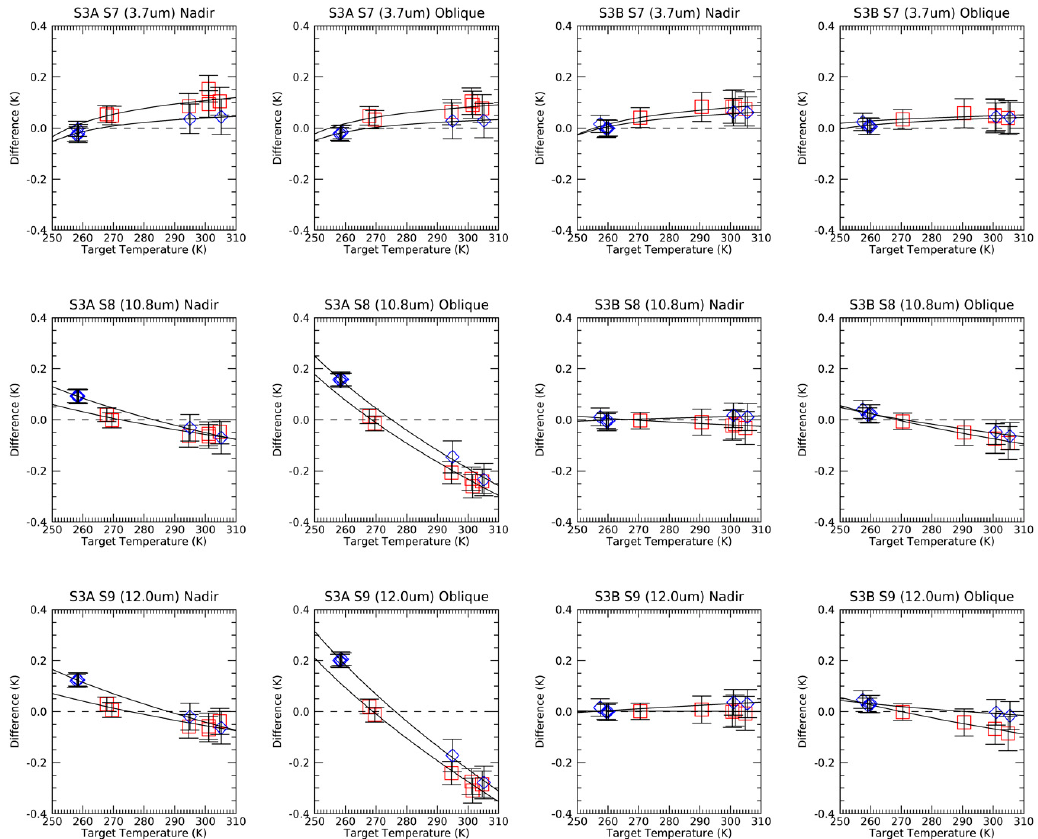
Figure 10. Results for all measurements where the external BB sources were at the same temperatures as the instrument s. The plot shows the differences between brightness temperatures of the external sources measured by SLSTR-A (left) and SLSTR-B (right) and the actual BB brightness temperatures. The red squares (cid:3) correspond to the normally heated + Y BB, the blue diamonds normally cold − Y BB. Error bars correspond to uncertainties at k =